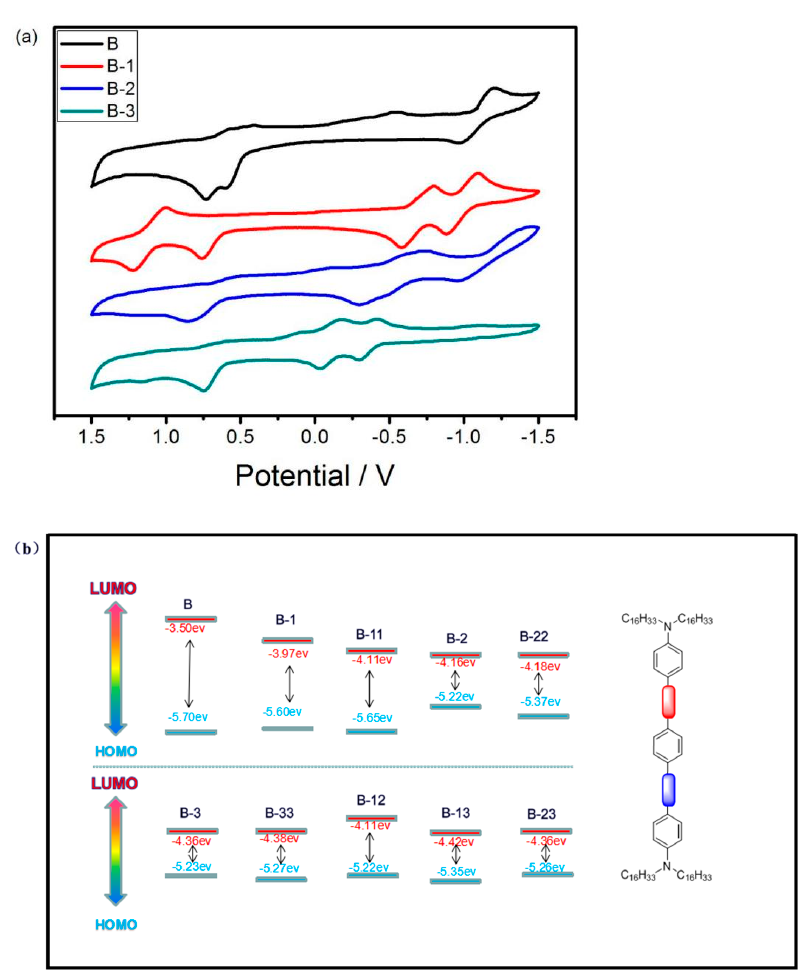
Figure 4. ( a ) Cycle voltammograms of B − X (B, B − 1, 2, and 3) in CH 2 Cl 2 /Bu 4 NPF 6 at rt; ( b ) LUMO and HOMO energy levels of all the compounds.